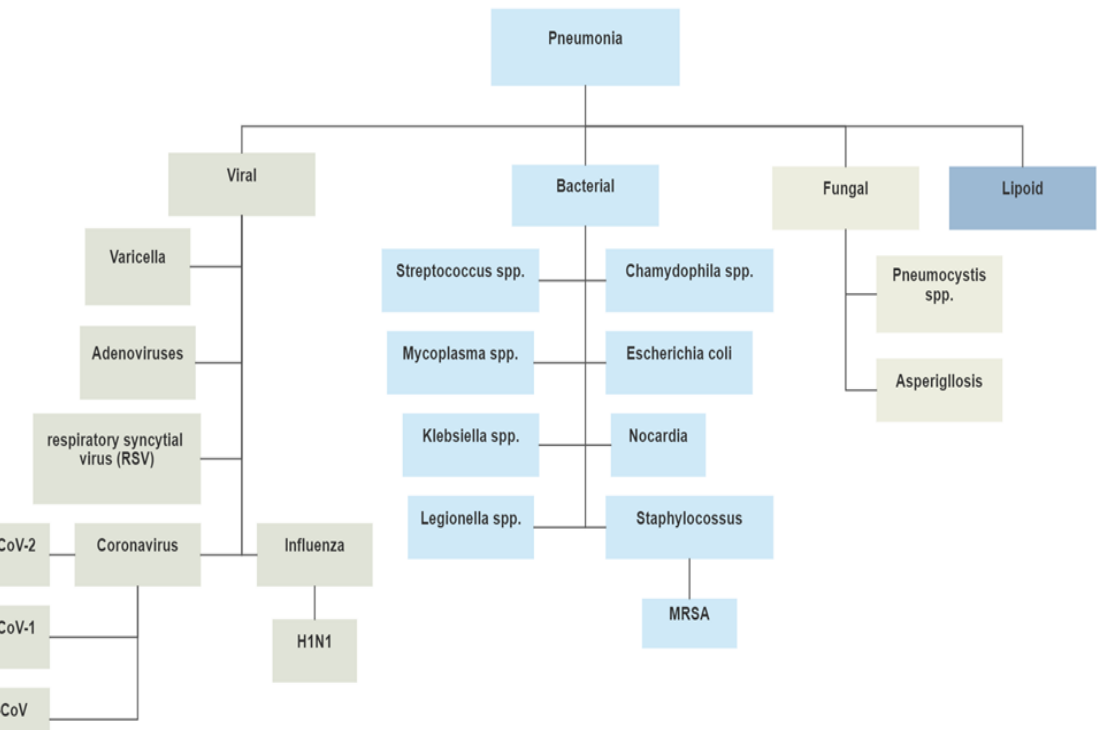
Figure 1. Hierarchical structure of the most prevalent pneumonia. The first human coronaviruses began to emerge worldwide in the 1960s. Six human viruses belong to the coronavirus family, four of which are associated with mild symptoms, similar to those of the common cold and gastrointestinal system infections. The other two viruses are marked by differences, including their highly pathogenic nature, namely, Middle East respiratory syndrome coronavirus (MERS-CoV), which first originated in Saudi Arabia in 2012, and severe acute respiratory syndrome coronavirus (SARS-CoV-1), which emerged in Asia in February 2003 [18,19]. Furthermore, their impact on endemic